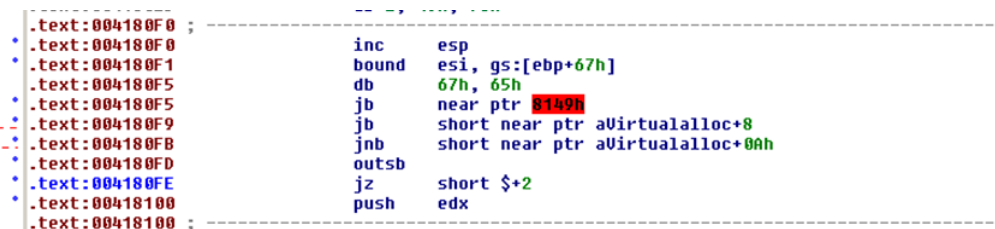
Figure 14. Ida Pro results.